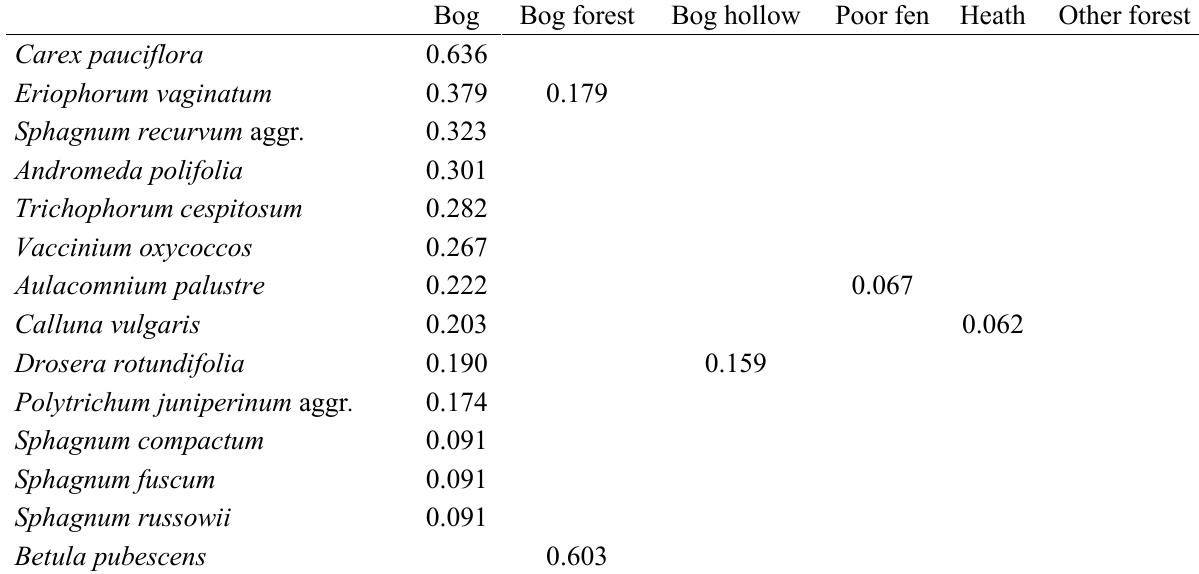
Table A1. Habitat specialists for selected habitats in Schwaendital. The INDVAL is given for a species if it is within the upper third of all INDVALs for the relevant